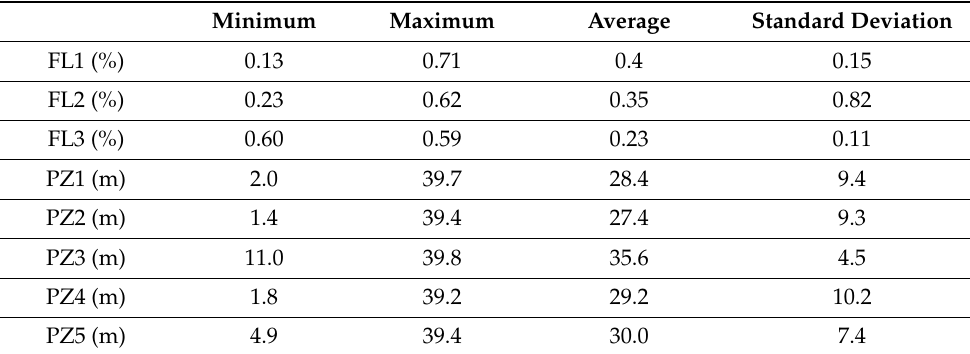
Table 4. Statistical descriptive parameters of the pressure and flow rate